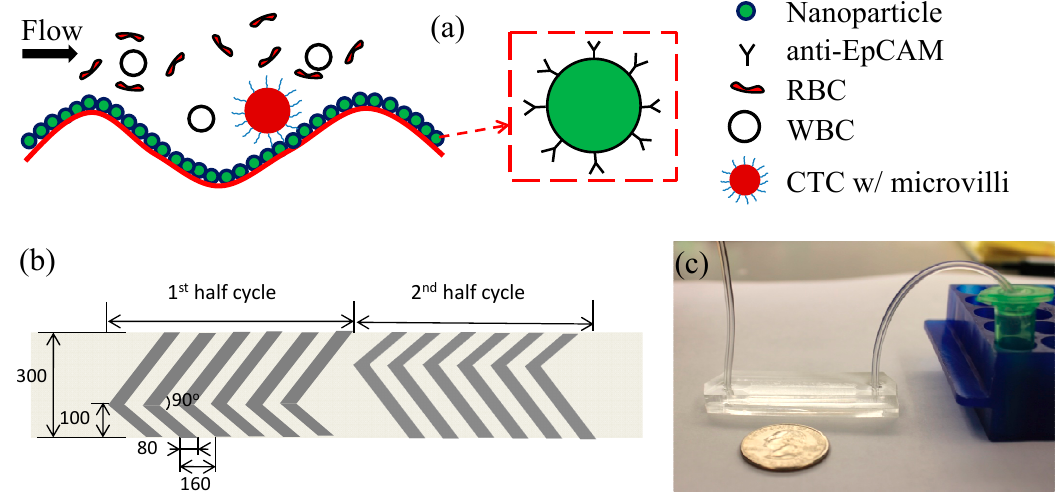
Figure 2. ( a ) Concept illustration of cancer cell capture in a microfluid chip with hierarchical micro / nanostructures. NPs coated with anti-epithelial cell adhesion molecule (EpCAM) are deposited on the wavy-HB pattern. ( b ) Illustrative geometry of a cycle of the wavy-HB pattern. Unit: µ m. ( c ) Photographic image of the test setting for the hierarchical circulating tumor cells (CTCs) capture chip.